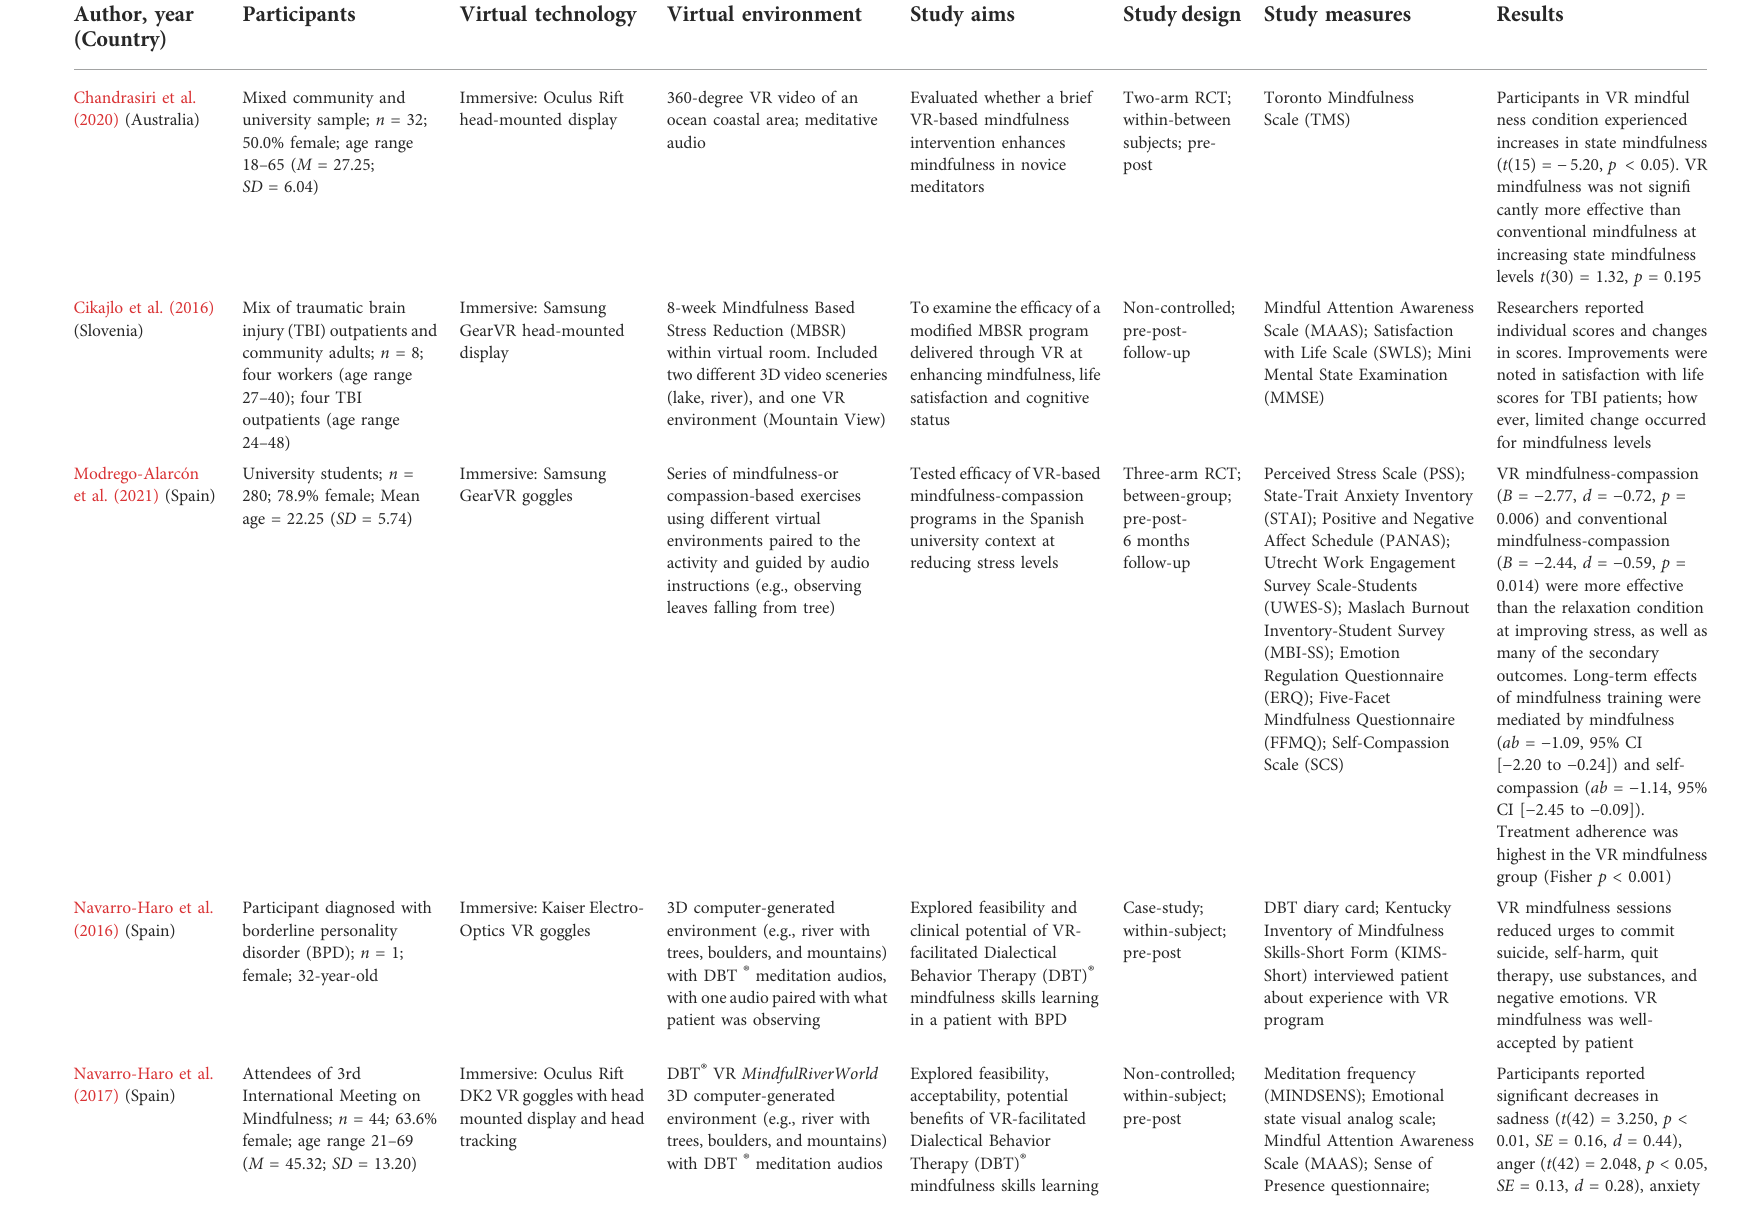
TABLE 3 Examples of empirical studies of mindfulness-based VR interventions for mental health and